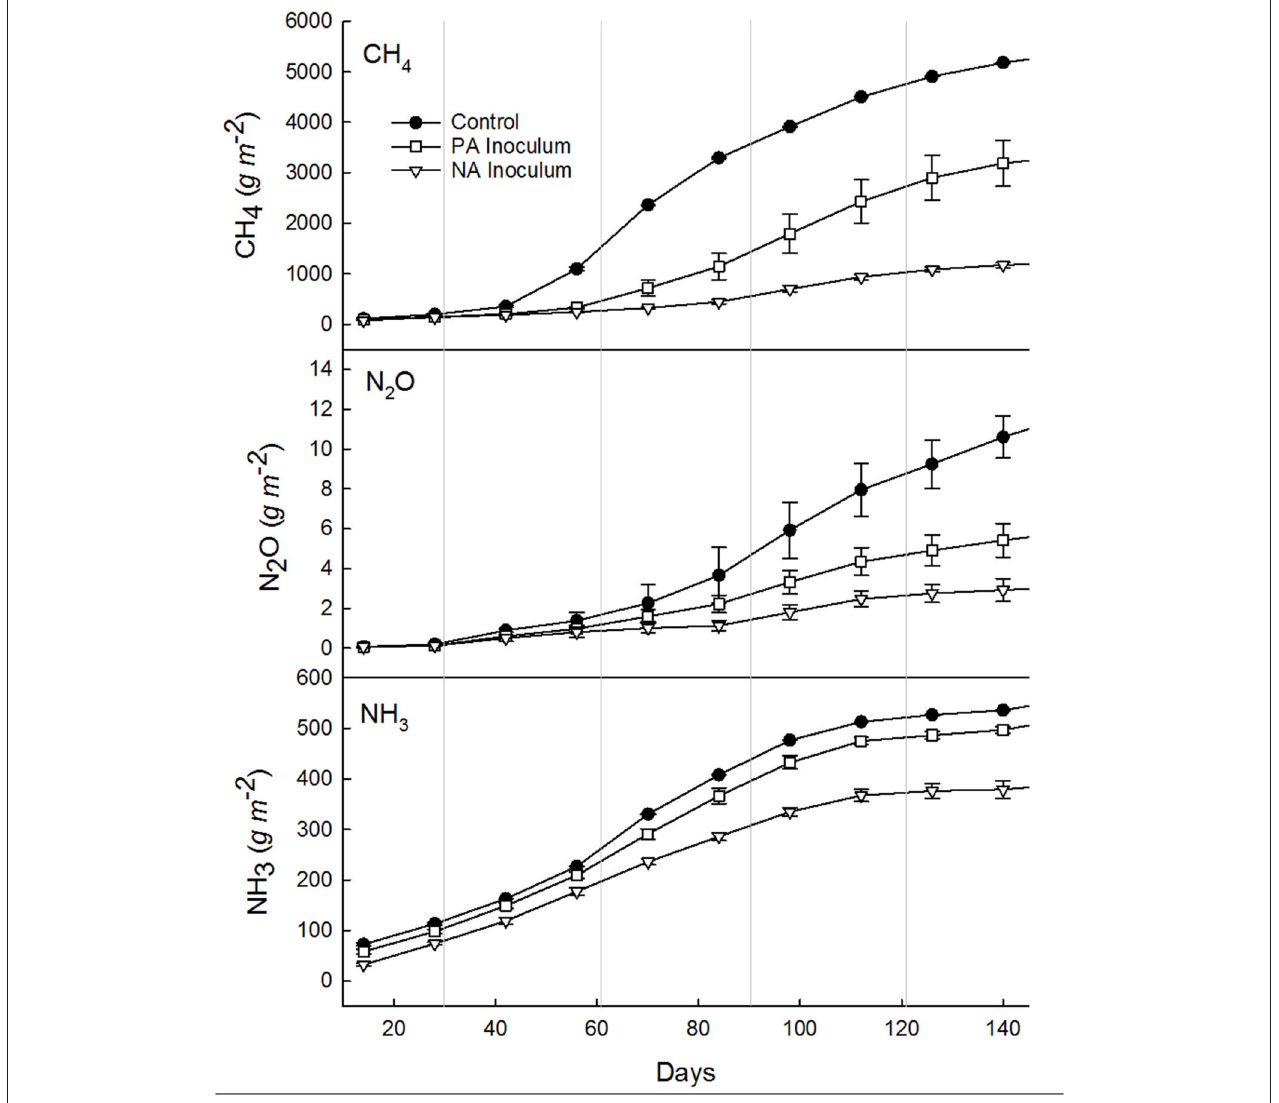
FIGURE 2 | Cumulative methane (CH 4 ), nitrous oxide (N 2 O), and ammonia (NH 3 ) emissions summed every 14 days over the entire study period (Jun 8–Oct 31; 145 days), from manure with untreated inoculum (control, •), manure with previously acidified (PA, (cid:3) ) inoculum, and manure with newly acidified (NA, ∇ ) inoculum. Vertical gray lines denote the end of a month, starting with June and ending with Nov. Error bars show standard deviation (note some error bars are too small to see).